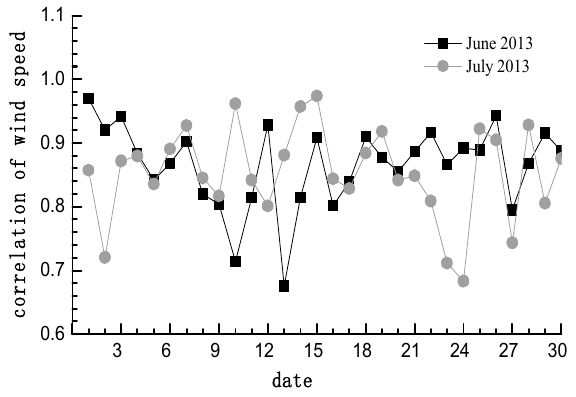
Figure 6. Statistical curve of WSC coefficient in different day.